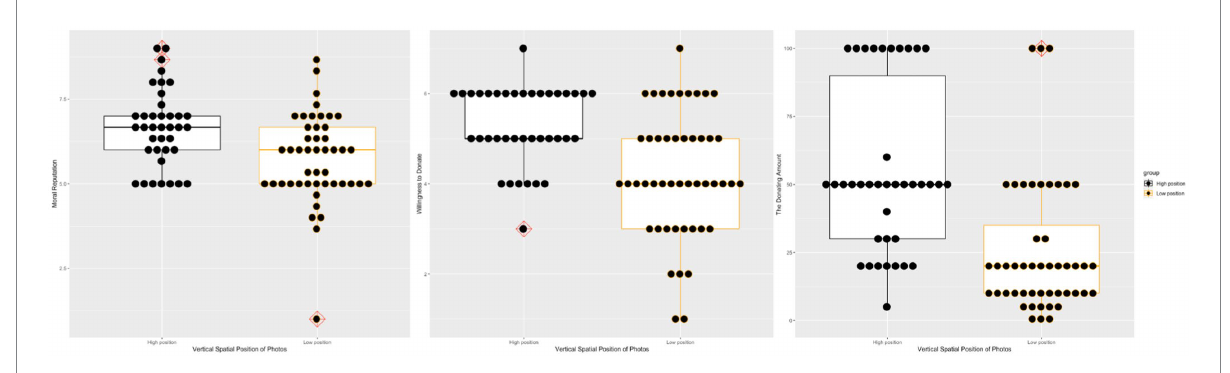
FIGURE 4 Two groups’ ratings about the donor recipient’s morality, willingness to donate, and the donation amount in Study